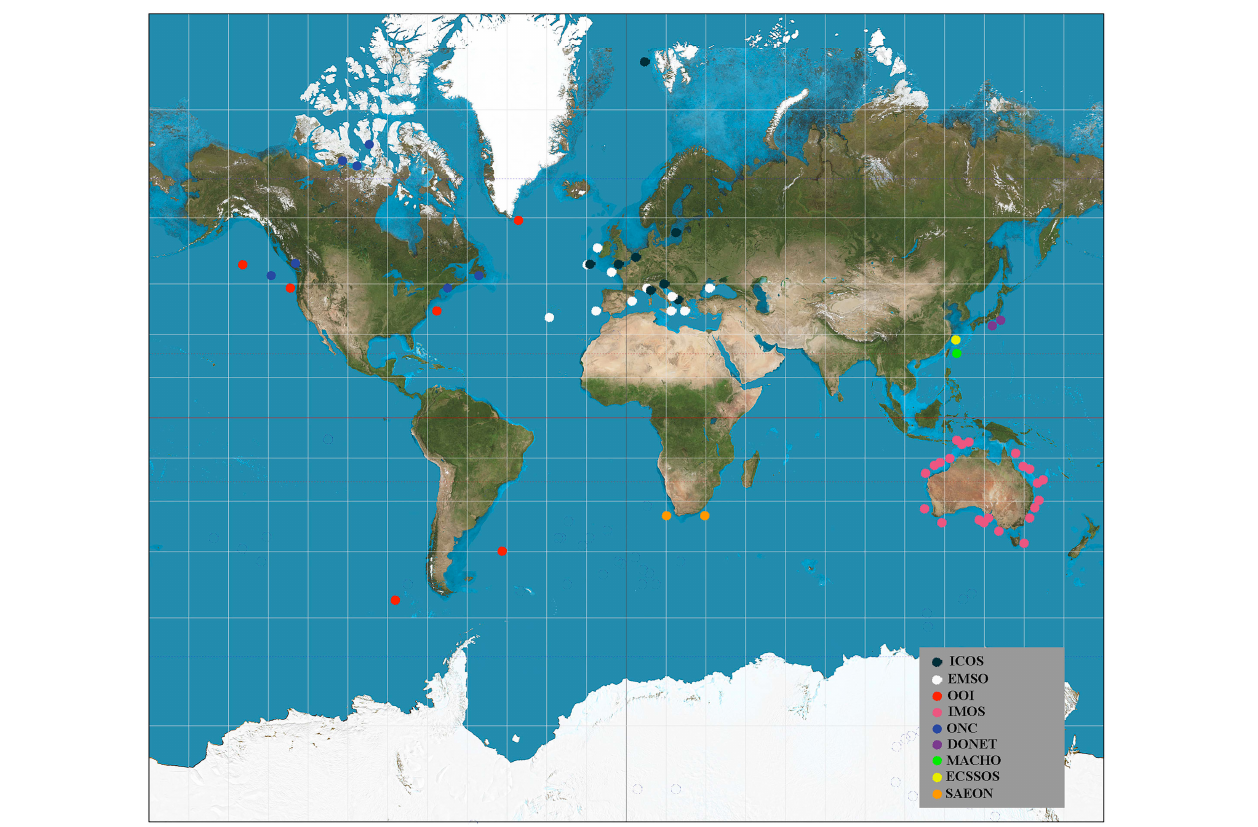
FIGURE 7 | Map of ocean long term observatories for in situ observations at a global scale across marine disciplines.